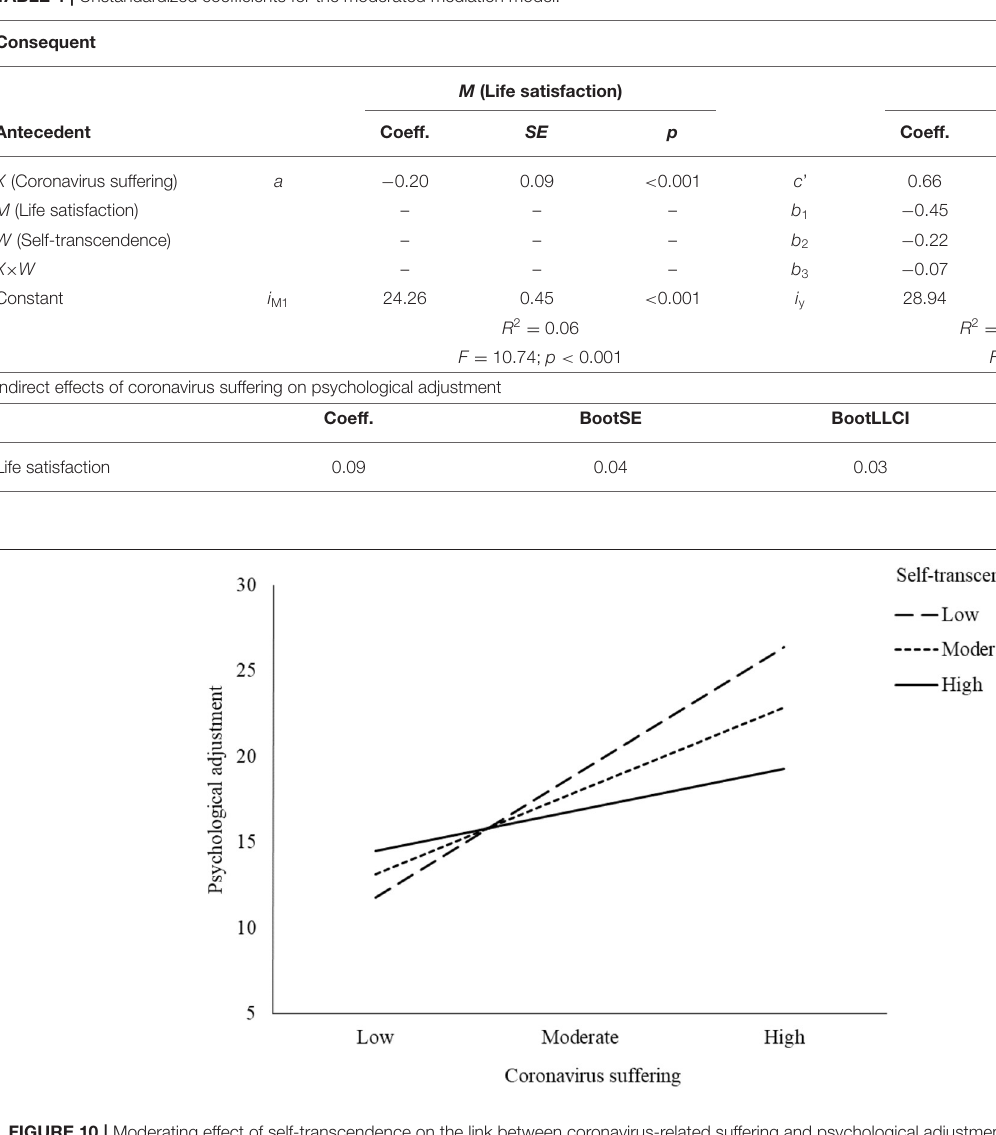
TABLE 4 | Unstandardized coefficients for the moderated mediation model.